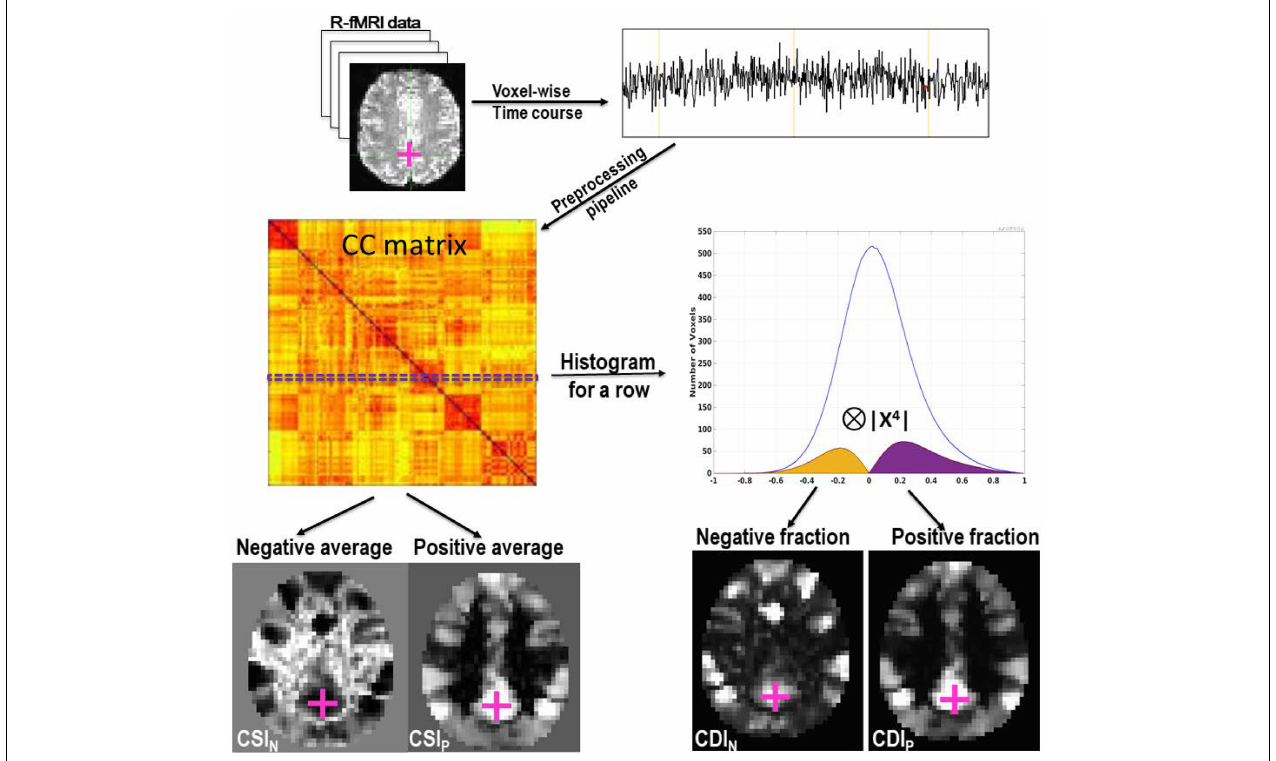
FIGURE 1 | A schematic overview to illustrate the QDA framework. With QDA the time course of each voxel is used in turn to compute the whole-brain CC matrix. For each row of the CC matrix, we compute a CC histogram with 200 evenly binned intervals within [ − 1, 1]. The histogram shown in the graph is the cohort’s average CC histogram for a voxel within the PCC as marked with the cross. Two types of RFC images are derived from the CC matrix: (1) CSI P and CSI N whose voxel values are the averages of the positives and negatives in each row of the CC matrix, respectively. (2) CDI P and CDI N whose voxel values are the positive and negative parts of the convolution between the CC histogram and the kernel,